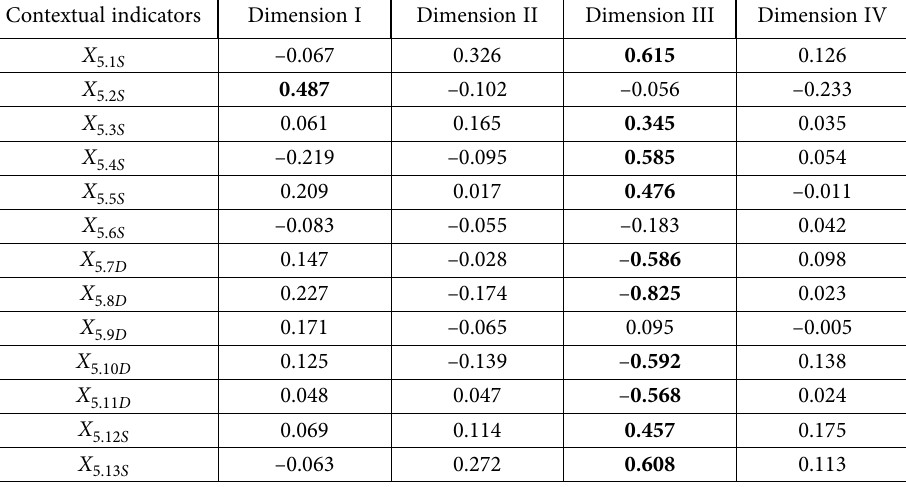
Table 10. Pearson r correlation coefficients determined for dimensions of green growth and contextual indicators Contextual